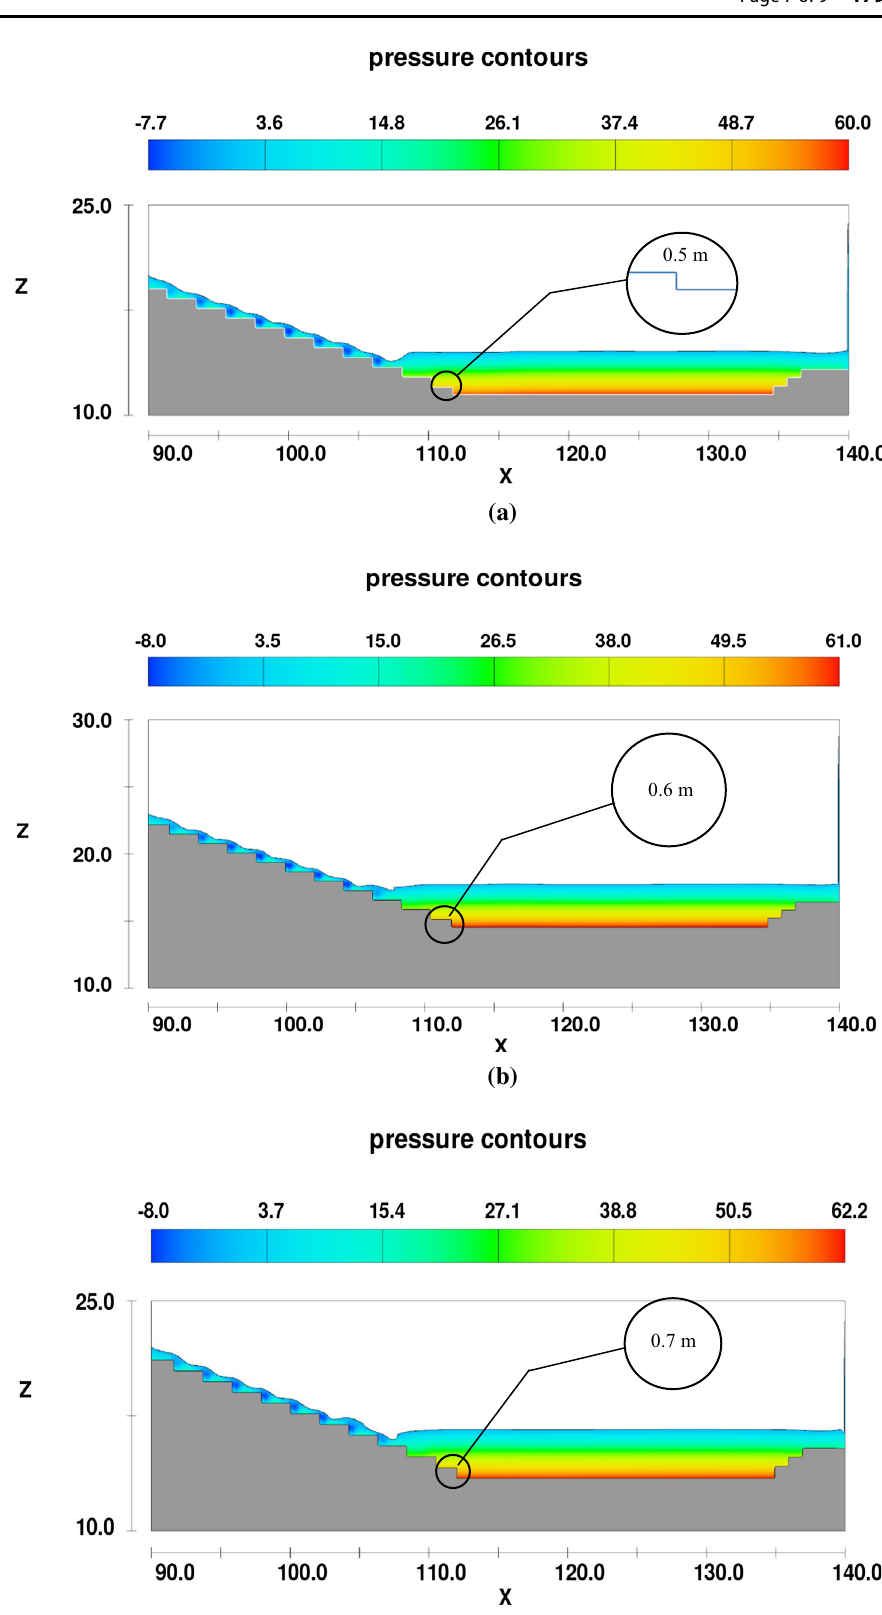
Fig. 6 Flow profiles on the still- ing basin with the height of the final step: a 0.50 m; b 0.60 m; c 0.70